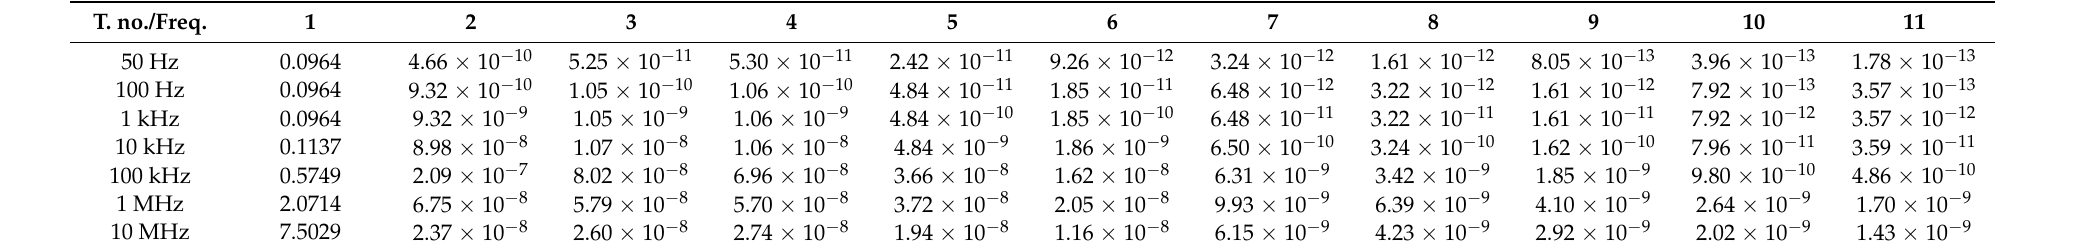
Table 5. Self and mutual resistances of turn 1 (in Ω ) resulting from FEM